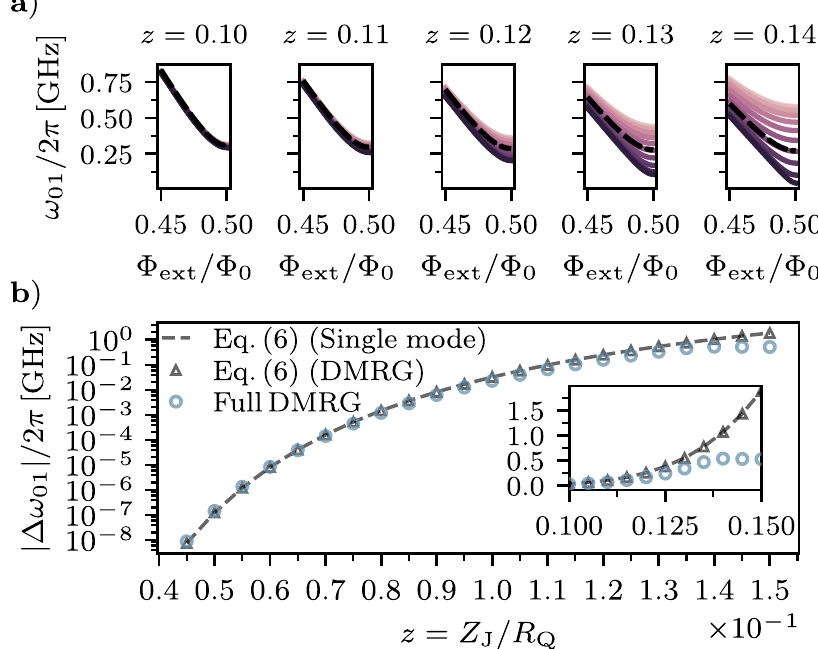
Fig. 3 Charge dispersion of a 40-junction superinductance fl uxonium qubit as a function of the reduced impedance of the array junctions. a Broadening of the fl uxon transition around Φ ext = Φ 0 /2 for n g ∈ [0, 0.5]. Color lines are obtained using the multi-targeted DMRG algorithm, while dashed black lines correspond to estimations using the single-mode Hamiltonian Eq. (4). b Total charge dispersion of the = Φ fl uxon transition at Φ ext 0 /2 according to the DMRG calculation (circles) contrasted to the prediction of Eq. (6) with matrix elements evaluated by means of DMRG (triangles) or the single-mode model (dashed lines). Inset: data displayed in linear scale. Parameters: C J = h ¼ 8 : 9 GHz , ω π = 12.5, and C = 0, according to ref. 9 E J p /2 0 b